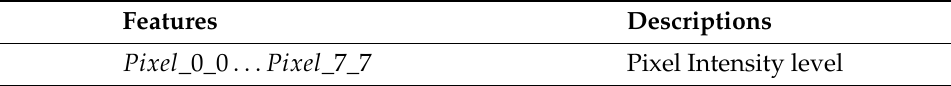
Table A4. Feature description for the digits dataset.